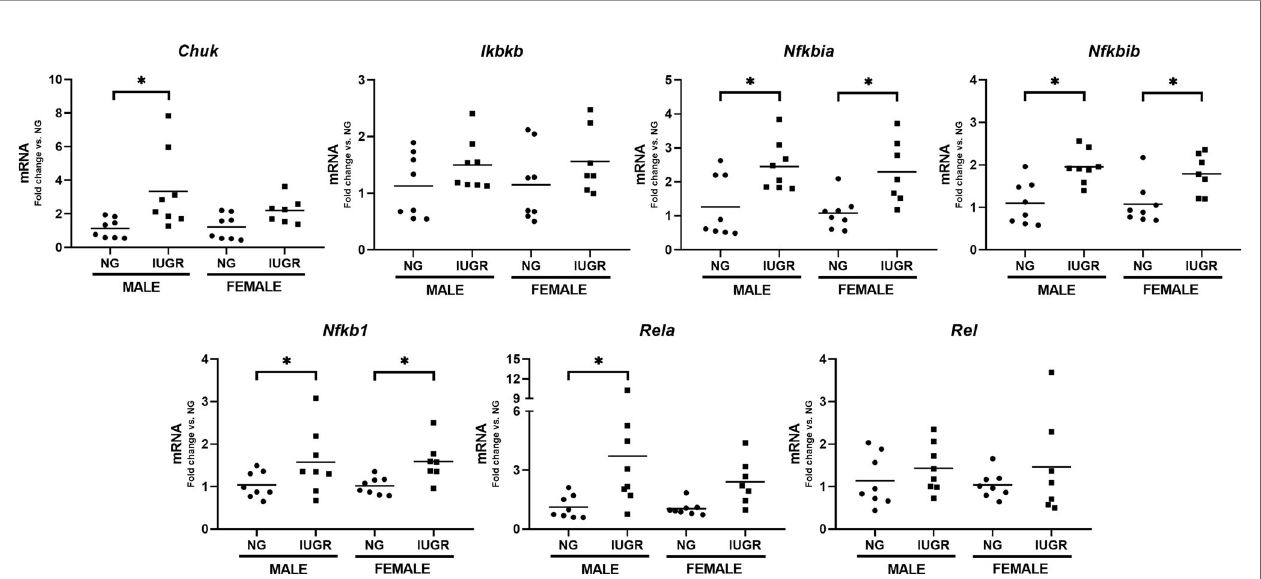
FIGURE 3 | Intra-uterine growth restriction (IUGR) induces changes in the neonatal NF- k B transcriptomic machinery. IUGR and normally (NG) male and female (P0) lives were collected and measured for gene expression of NF- k B key factors. Mouse 18s gene was used a housekeeping gene. * P <0.05 vs . NG by the Mann- Whitney test. Values are represented as fold change compared to their respective control (NG).